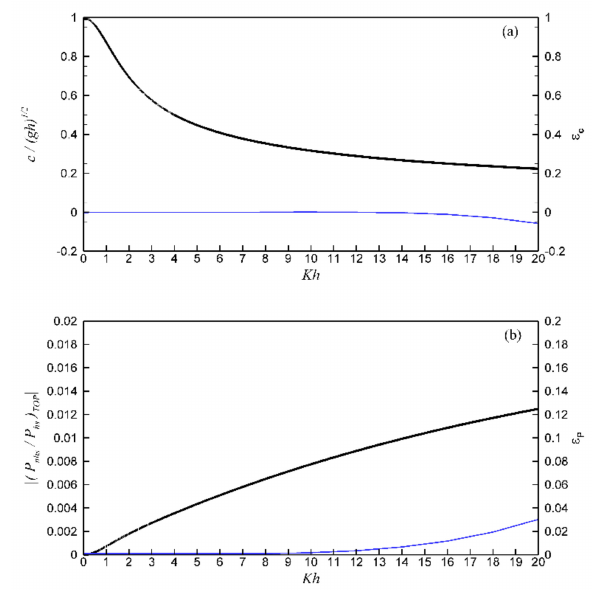
Figure 4. Sensitivity analysis of the physical and modeled non-hydrostatic e ff ects on the phase velocity of linear dispersive waves under di ff erent Kh : ( a ) wave speed and phase error ε c and ( b ) non-hydrostatic contribution and pressure error ε P at the top layer: analytical solution (bold solid lines) and FNHS mode (solid